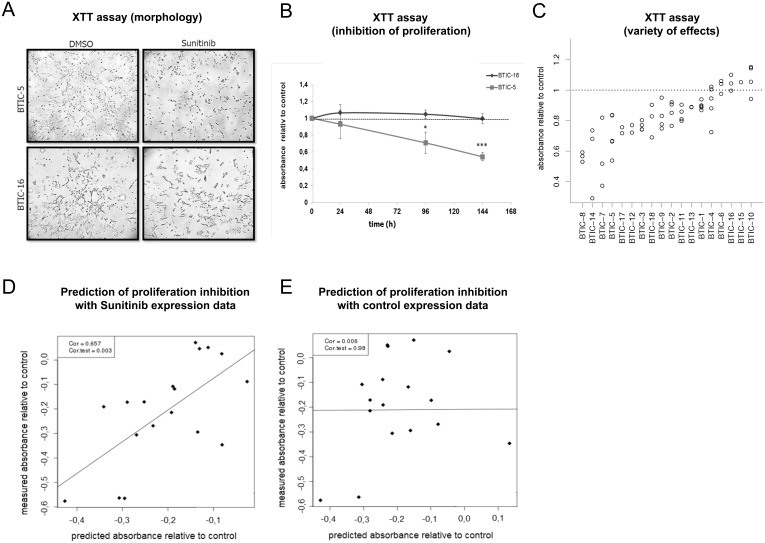
Cellular growth and proliferation under Sunitinib treatment.BTICs were incubated with 1 µM Sunitinib or 0.00025% DMSO (control), and the XTT proliferation assay was performed after 96 h. Each individual assay was performed with five replicates per treatment group. The assay was repeated at least three times for each cell line. (A) Growth pattern in a responding (BTIC-5) and a non-responding (BTIC-16) BTIC line. Representative pictures are shown for two differently responding BTIC lines. (B) The mean absorbance of Sunitinib treated cells relative to control cells obtained in an individual assay was assessed after 24 h, 96 h and 144 hours incubation period and is plotted in a dot blot graph (y-axis) against incubation time (x-axis). (C) The relative difference of the mean proliferation relative to control is blotted in a dot blot graph (y-axis) against the corresponding BTIC line (x-axis). Each data point indicates the result of an individual experiment. The assay shows the variety of effects in the investigated lines. (D) Prediction of proliferation based on gene expression 6 h after treatment in vivo. The x-axis shows cross validated predictions of proliferation response after 96 hours based on gene expression levels monitored 6 hours after treatment, while the y-axis shows the actual proliferation measurements after 96 hours. The correlation between predicted and measured proliferation is significant (p<0.01, chi-square test). (E) Failed prediction of proliferation using expression values from untreated samples. There is no significant correlation between predictions and measurements (p = 0.98).